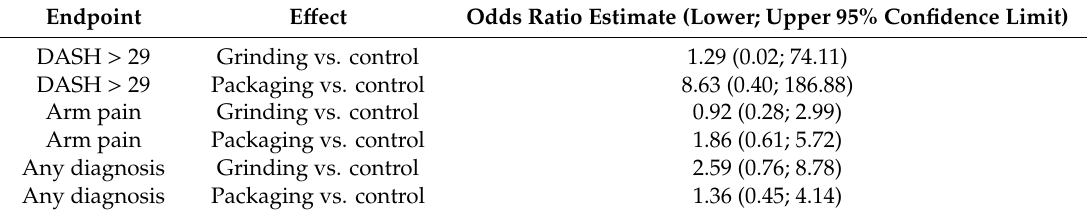
Table 9. Odds ratios for important